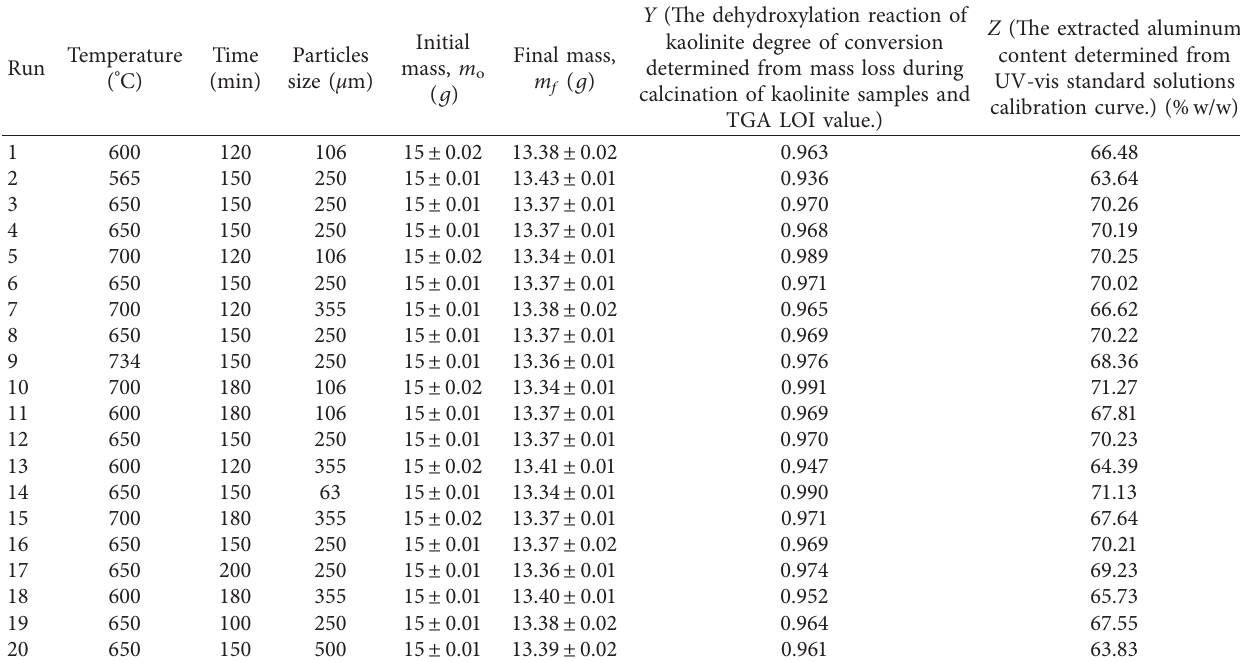
Table 3: CCD experiments for optimization of calcination parameters on responses: degree of conversion of kaolinite dehydroxylation reaction ( Y ) and extracted aluminum ( Z